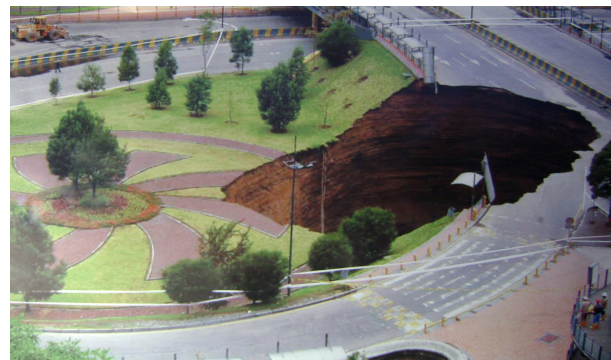
Figure 2. Initial stage of sinkhole at El